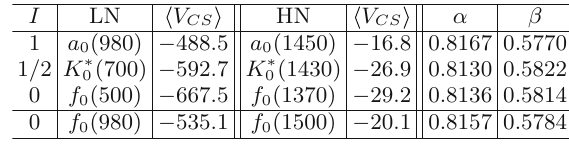
Table 1 The light nonet (LN) and heavy nonet (HN) in the J P = 0 + Table 2 Here are the physical hyperfine masses, (cid:6) V CS (cid:4) , and the mixing parameters, α , β ,forthetwononetscalculatedseparatelyineachisospin channel collected from PDG [1] are listed here along with the isospin, ( 700 ) , which are now channel [21]. Note, α , β , are almost the same regardless of the isospin mass, the total width. The masses of f 0 ( 500 ) , K ∗ 0 channel. See the text for the physical meaning of α , β . (cid:6) V CS (cid:4) is